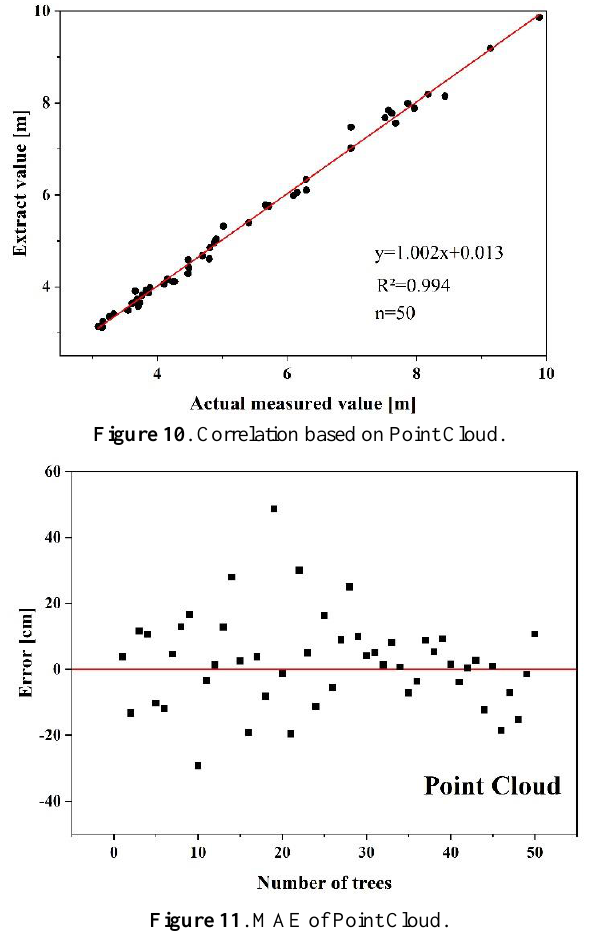
Figure 11 . MAE of Point